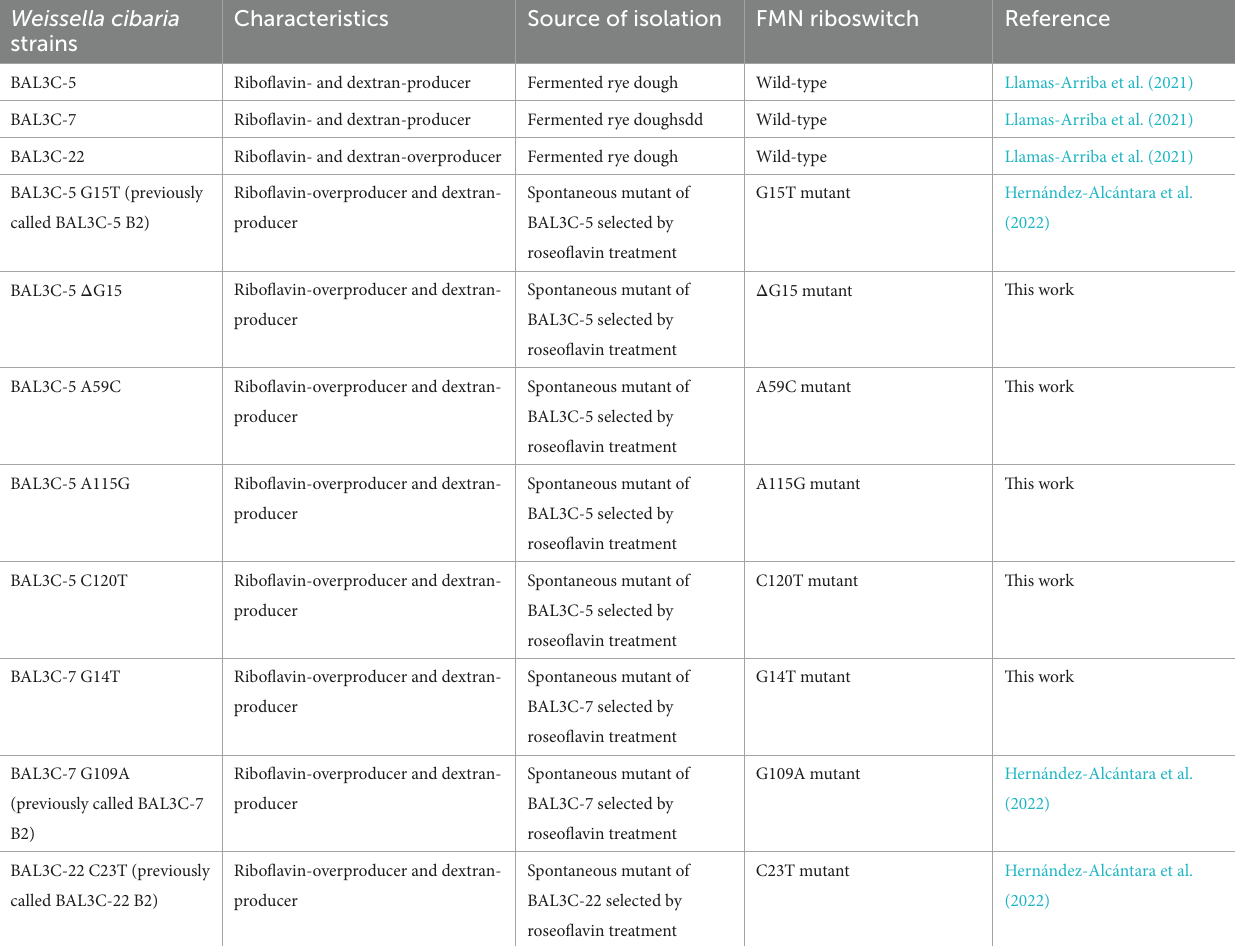
TABLE 1 Bacterial strains used in this work.